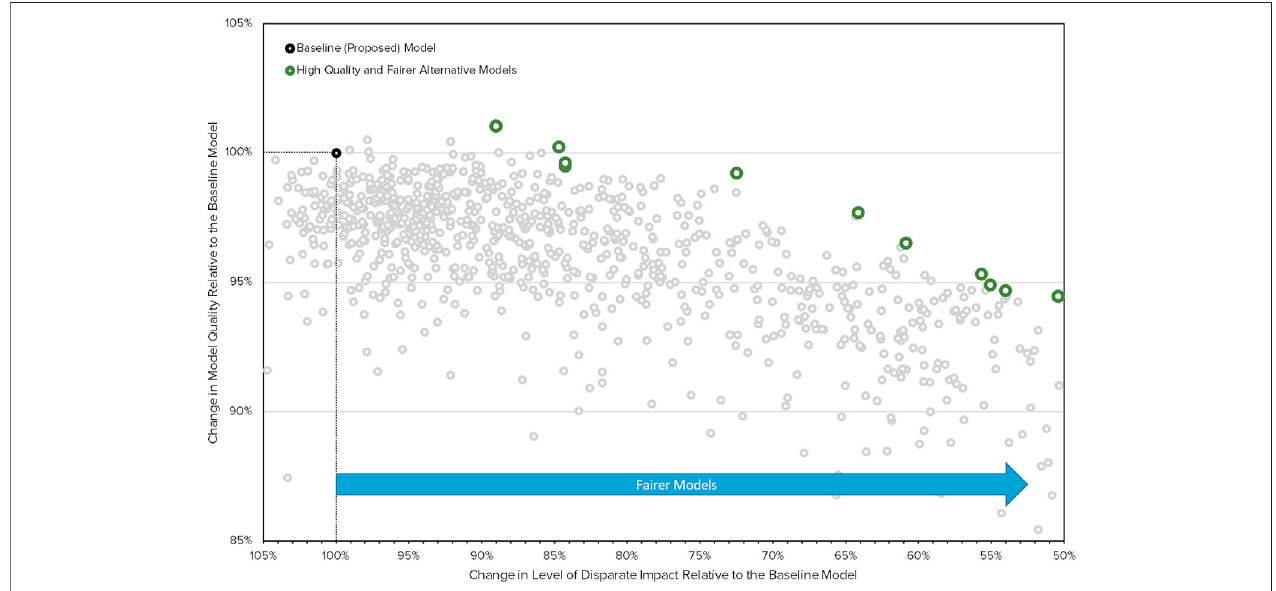
FIGURE 1 | Results from a multi-objective evolutionary search procedure in which several lending models are found that retain the performance quality, but decrease disparate impact, in a realistic lending